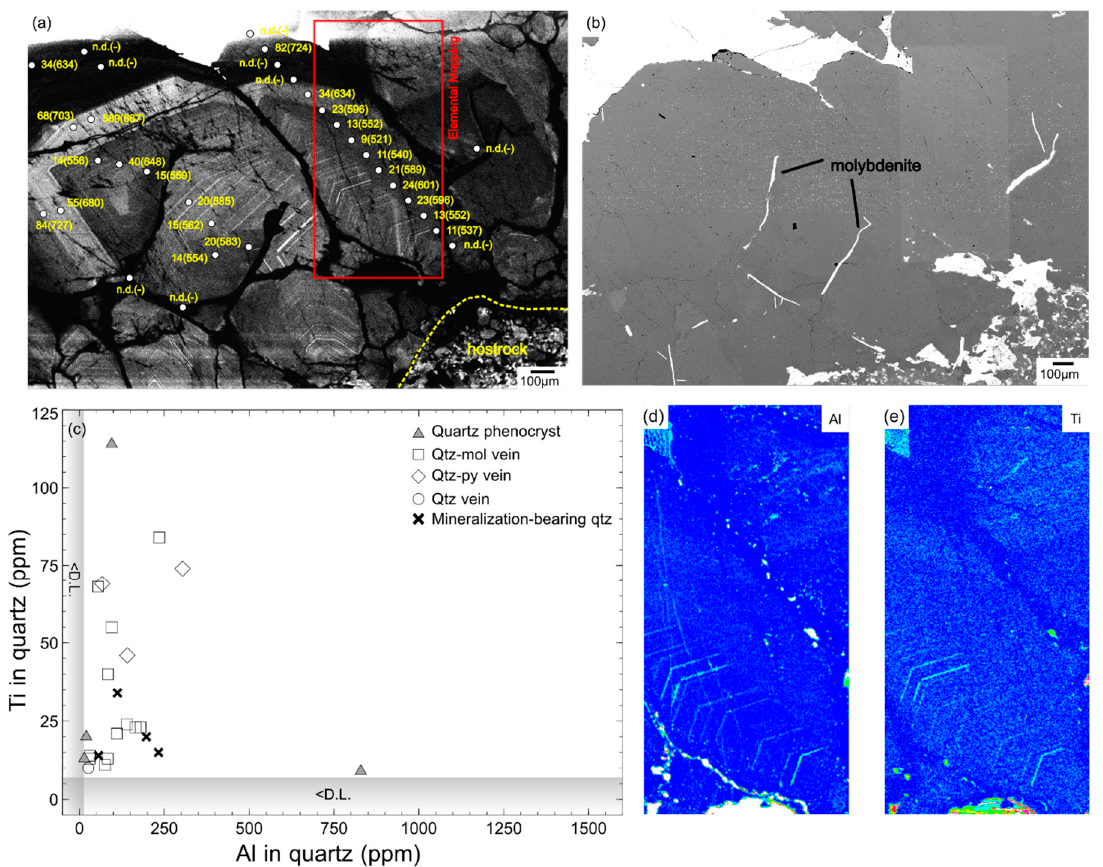
Figure 7. Representative qtz–mol vein. ( a ) SEM–CL image. ( b ) BSE image showing Ti analyses. The estimated temperature is shown in parentheses. ( c ) Ti and Al concentrations of quartz. ( d , e ) Trace element maps showing a positive relationship between CL-brightness, Ti, and Al.